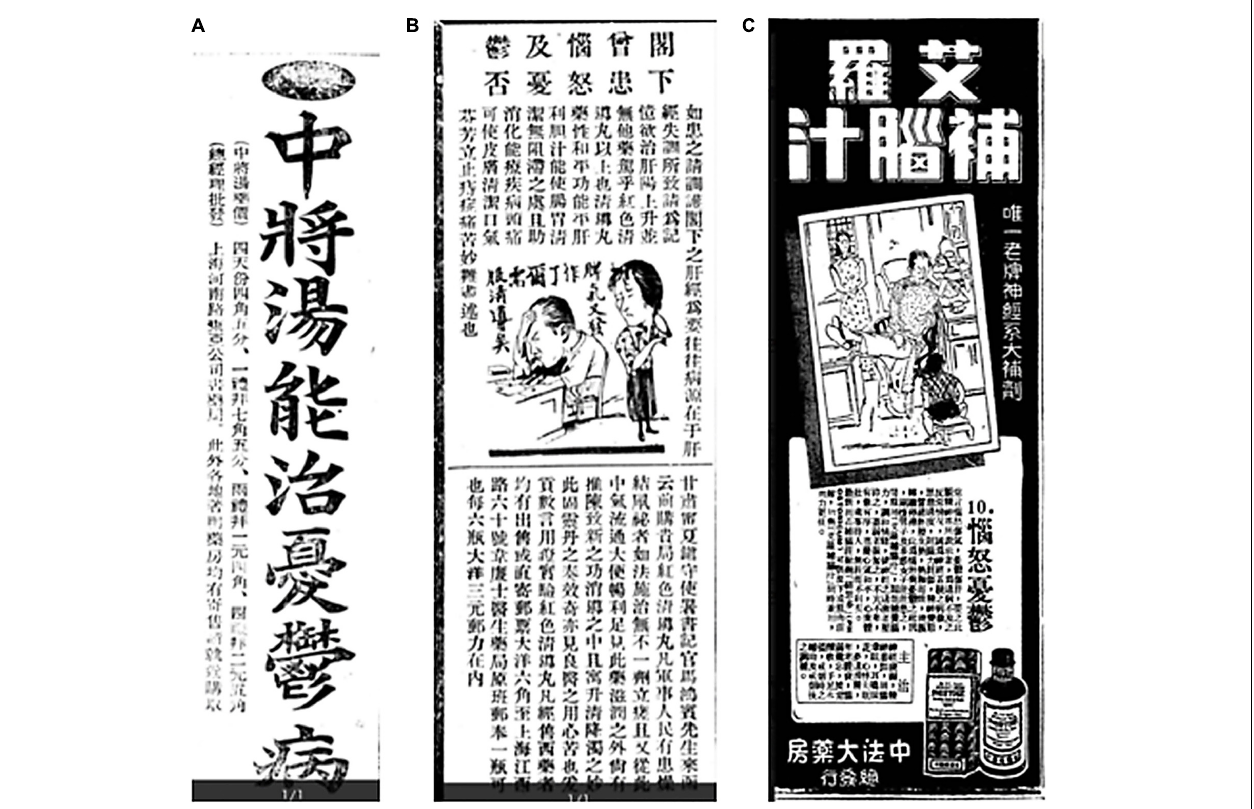
FIGURE 1 | (A) Advertisement of Zhongjiang Tang . Source: Times ( ), 1 April 1913. (B) Advertisement of the Red Qingdao pill. Source: Republic of China Daily ( ), 31 March 1925. (C) Advertisement of Ailuo Brain Tonic. Source: The News ( ), 29 November